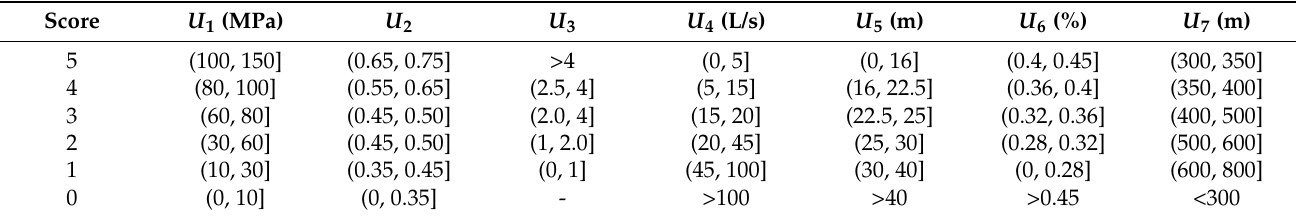
Table 17. Evaluation standard.